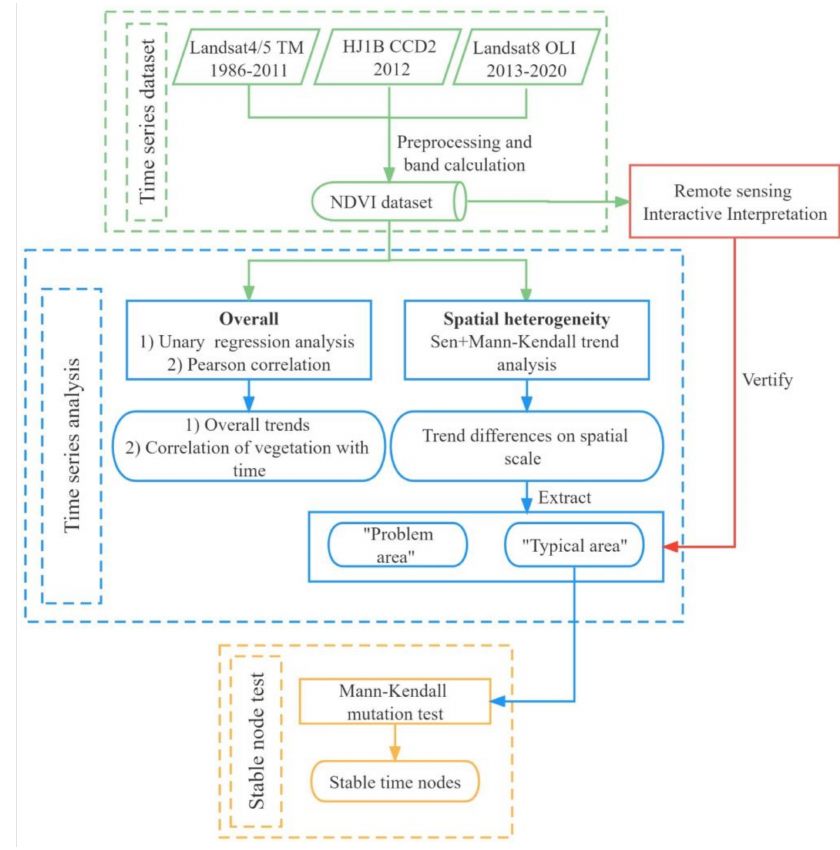
Figure 2. Overview of the technical workflow for this